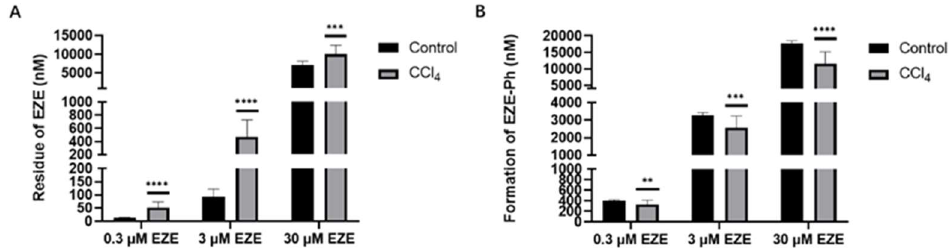
Figure 6. Residue of EZE ( A ) and formation of EZE-Ph ( B ) in liver S9 of control and CCl 4 -induced rats after incubation with 0.3 µ M, 3 µ M, and 30 µ M EZE for 60 min. Data are expressed as mean ± S.D. ( n = 3). ** p < 0.01, *** p < 0.001, and **** p < 0.0001 compared with